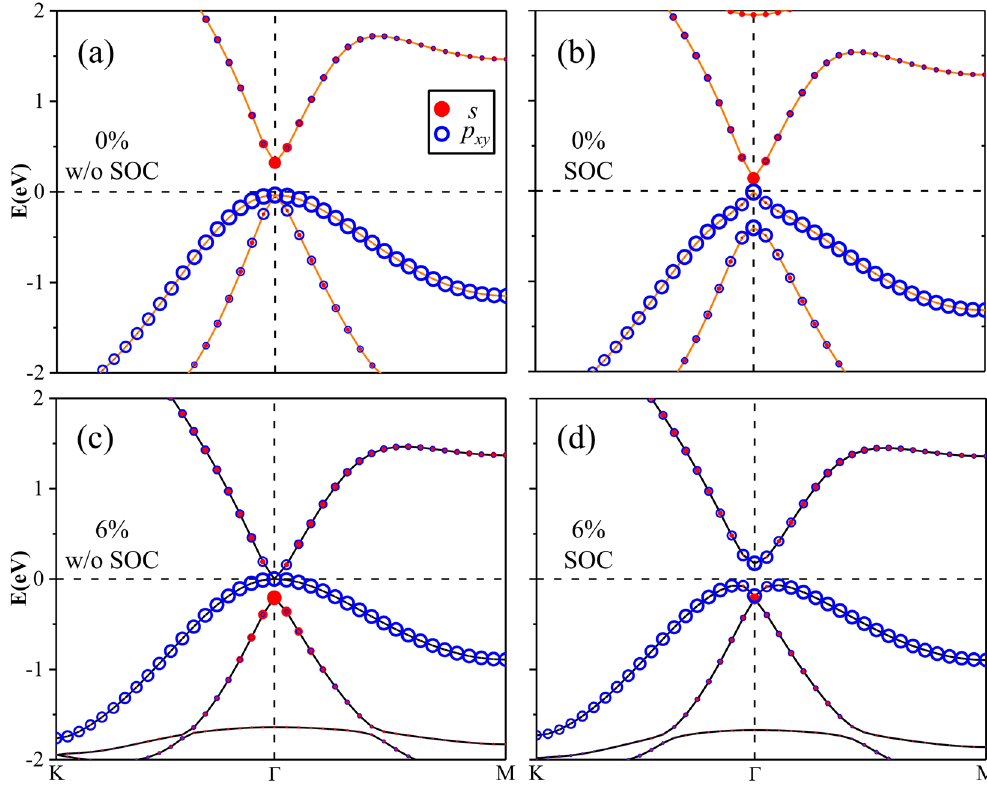
Figure 2. Band structures of SnCH 3 film ( a ) without SOC and ( b ) with SOC under strain of 0%. Band structures of SnCH 3 film ( c ) without SOC and ( d ) with SOC under strain of 6%. The radius of red dots and blue circles indicate the weight of s and p xy orbitals. The Fermi level is set to